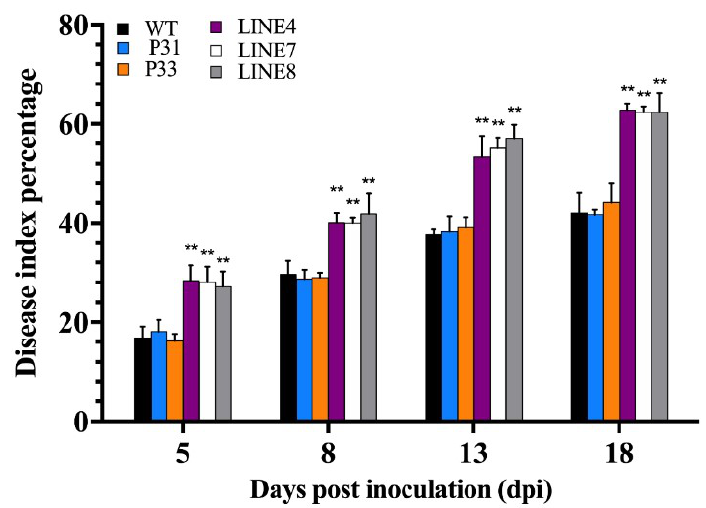
Figure 12. Disease index percent of transgenic (line 4, line 7, and line 8), empty vector (P31, P33), and wild-type lines after inoculation with P. capsici and the disease index percent were calculated at 5, 8, 13, and 18 d. The data of disease index percent was analyzed between the transgenic lines (line 4, line 7, and line 8) and the wild-type and empty vector transgenic lines (P31 and P33) at the same time point using the least significant difference (LSD). ** represents highly significant difference at p ≤ 0.01. Mean values and SEs are shown.